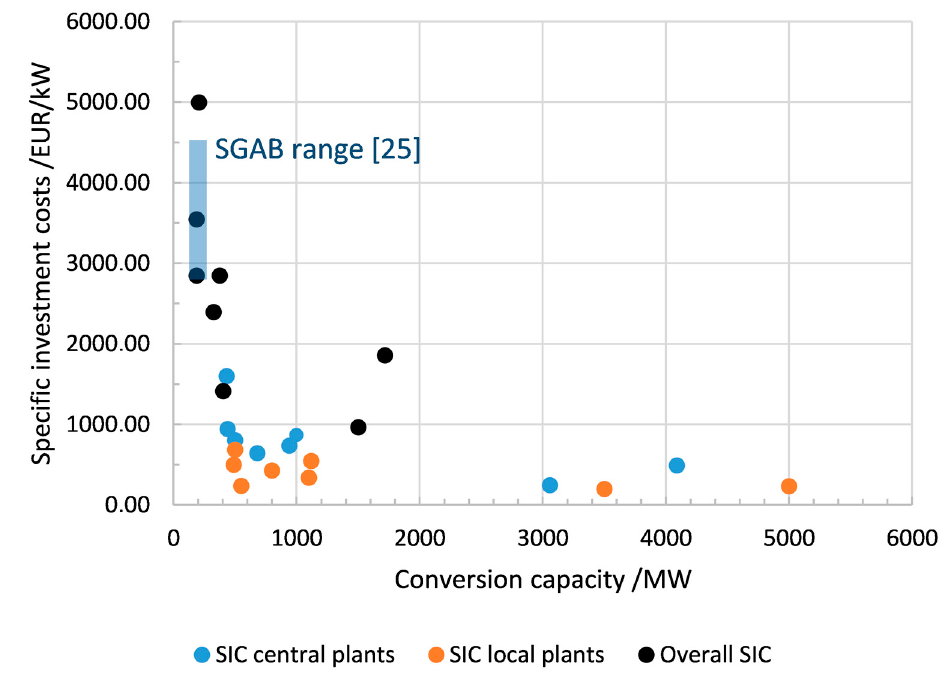
Figure 5. Specific investment costs (SIC) for summarized local and central conversion plants and overall SIC.